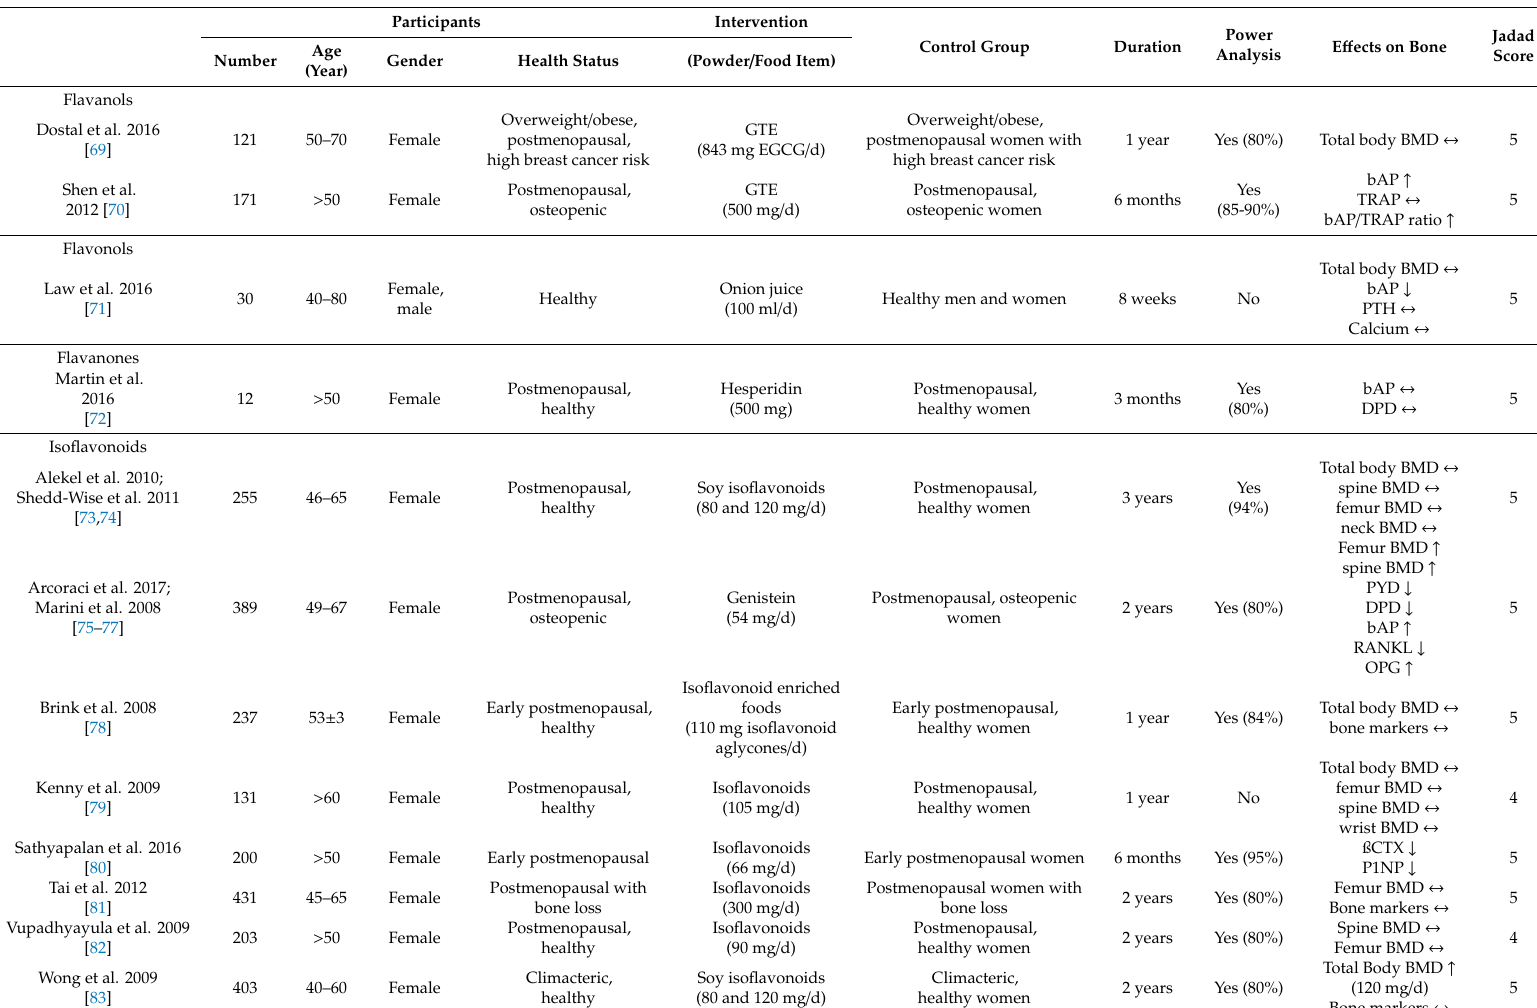
Table 1. Overview of human intervention studies